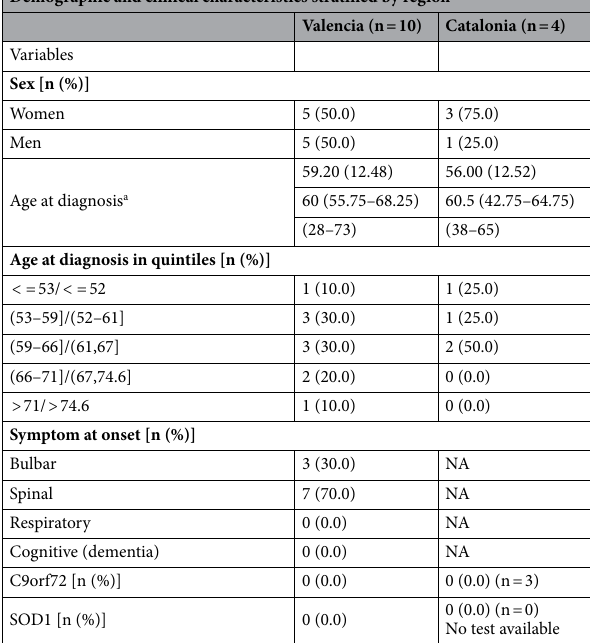
Table 3. Descriptive analysis of demographic and clinical characteristics by region for each of the diagnostic categories. Primary Lateral Sclerosis (PLS). a First row: mean (sd). Second row: median (1st–3rd quartiles). Third row: